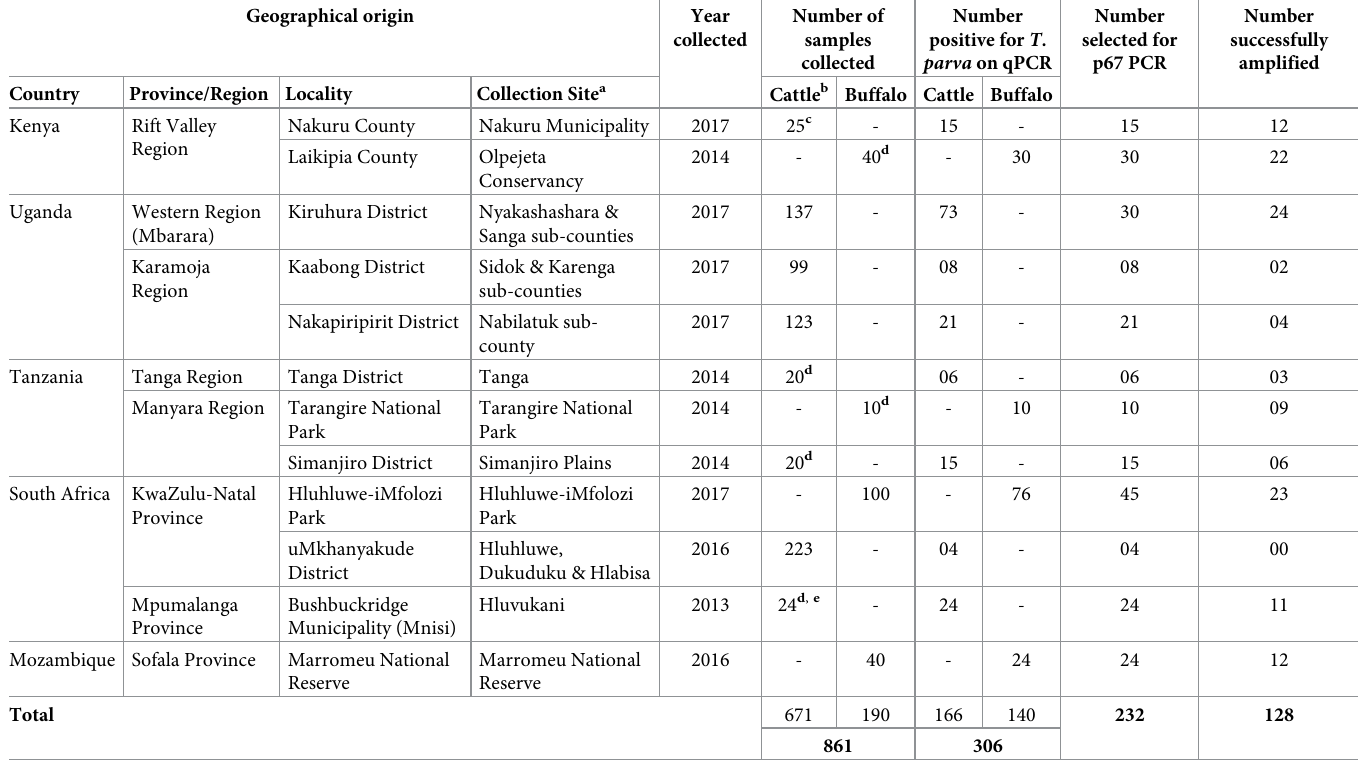
Table 1. The geographical origin of blood samples collected from East and southern